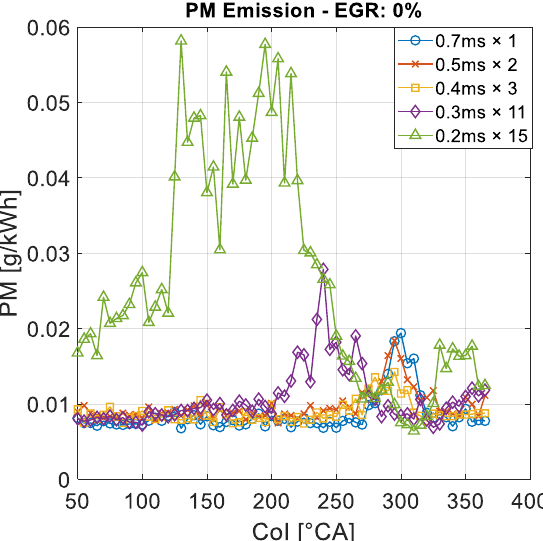
Figure 10. The PM emission of the investigated structures with the same dose in the function of CoI without EGR.